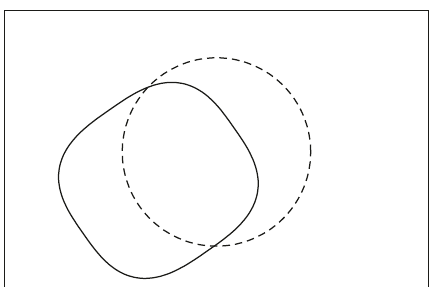
Figure 14: Shapes of Model 4 before and after optimization.